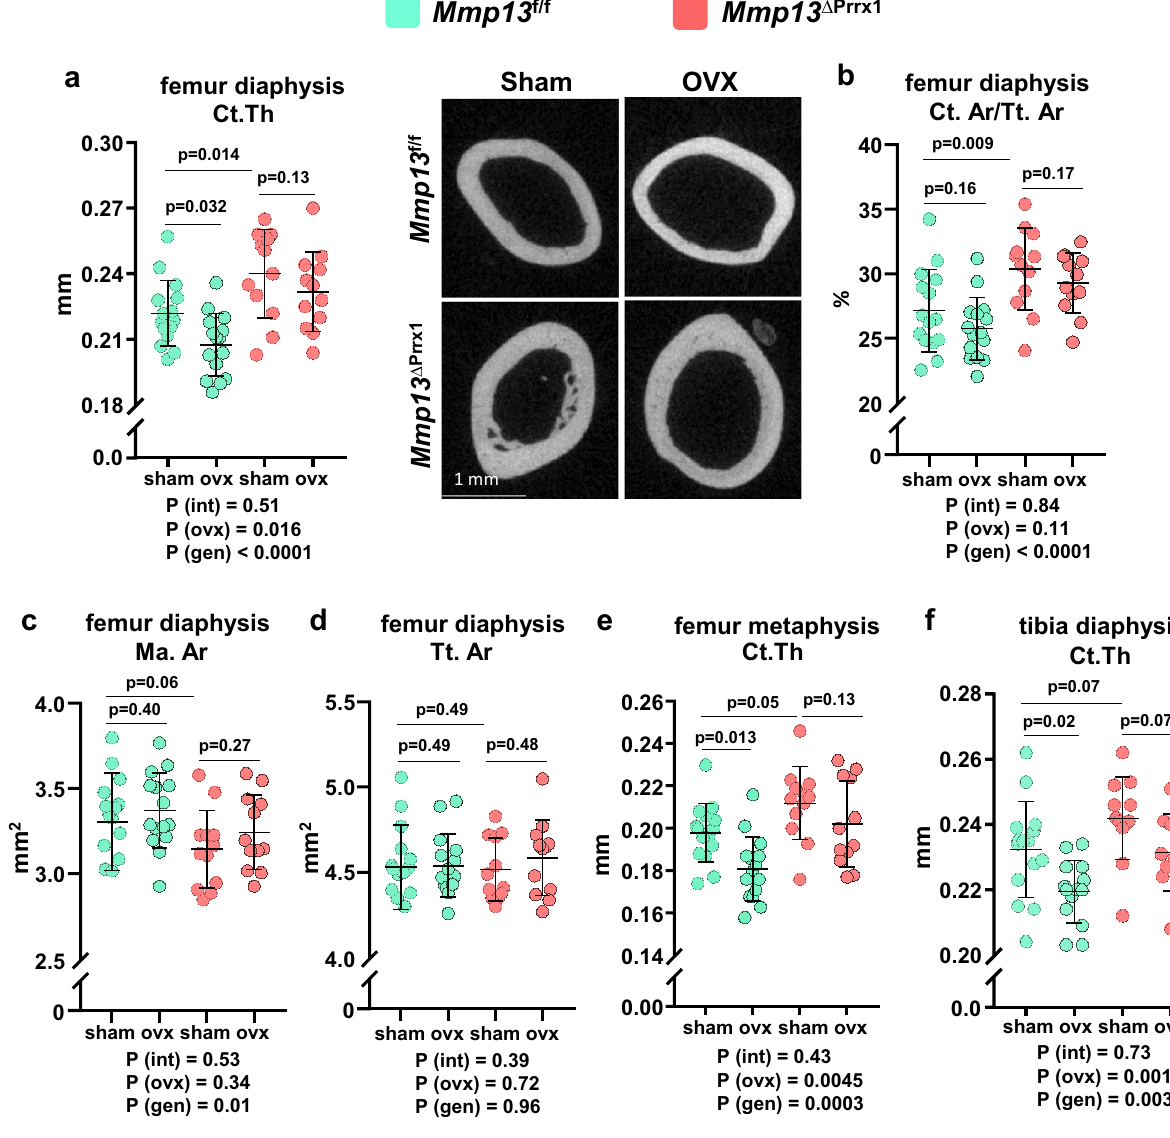
Figure 3. Mmp13 deletion increases cortical bone and attenuates the cortical bone loss caused by ovariectomy. Femur and tibia cortical bone were evaluated by micro-CT. ( a ) Cortical thickness measured in diaphysis (mid- shaft) and representative micro-CT images of the same region of the femur. ( b ) Cortical area under total area, ( c ) medullary area and ( d ) total area measured in mid-shaft femur. ( e ) Cortical thickness measured at distal metaphysis of the femur. ( f ) Cortical thickness measured in the diaphysis (mid-shaft) of the tibia. Data represent mean ± S.D. (n = 12–15 mice/group); P values by 2-way ANOVA, interaction terms are shown below each